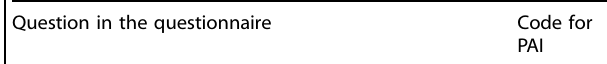
Table 3. The assessment of physical activity and creation of the PAI in 1980 –